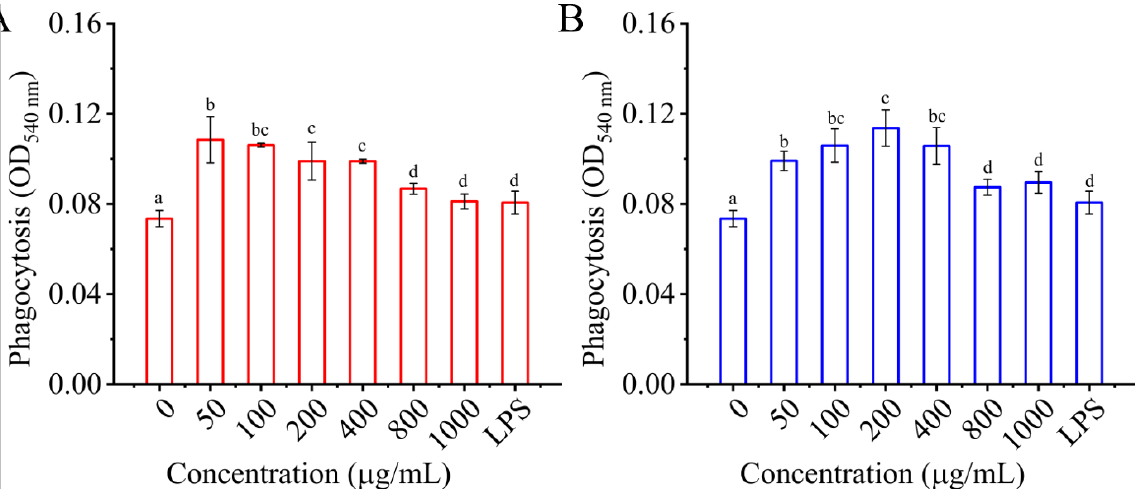
Figure 5. The effect of I01-2 ( A ) and I01-4 ( B ) on the phagocytosis of RAW 264.7 cells. The group was incubated with medium (0 μg/mL of I01 -2 and I01-4) as a negative control and LPS (1.0 μg/mL) treatment as a positive control. Different superscript letters (a–d) indicate significant differences ( p < 0.05) between the groups.